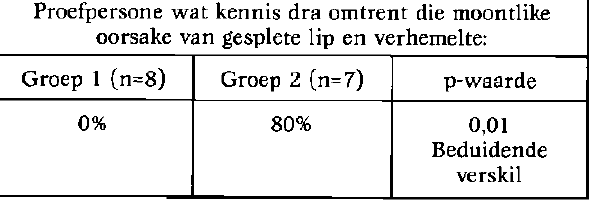
Tabel 5: Vooruitsigte van